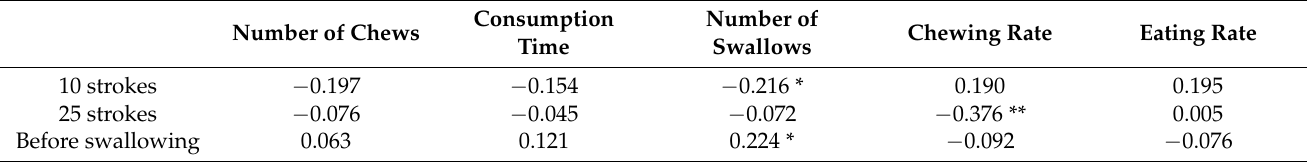
Table 3. Spearman’s Rho correlation coefficient between oral processing parameters and saliva incorporation. Number of